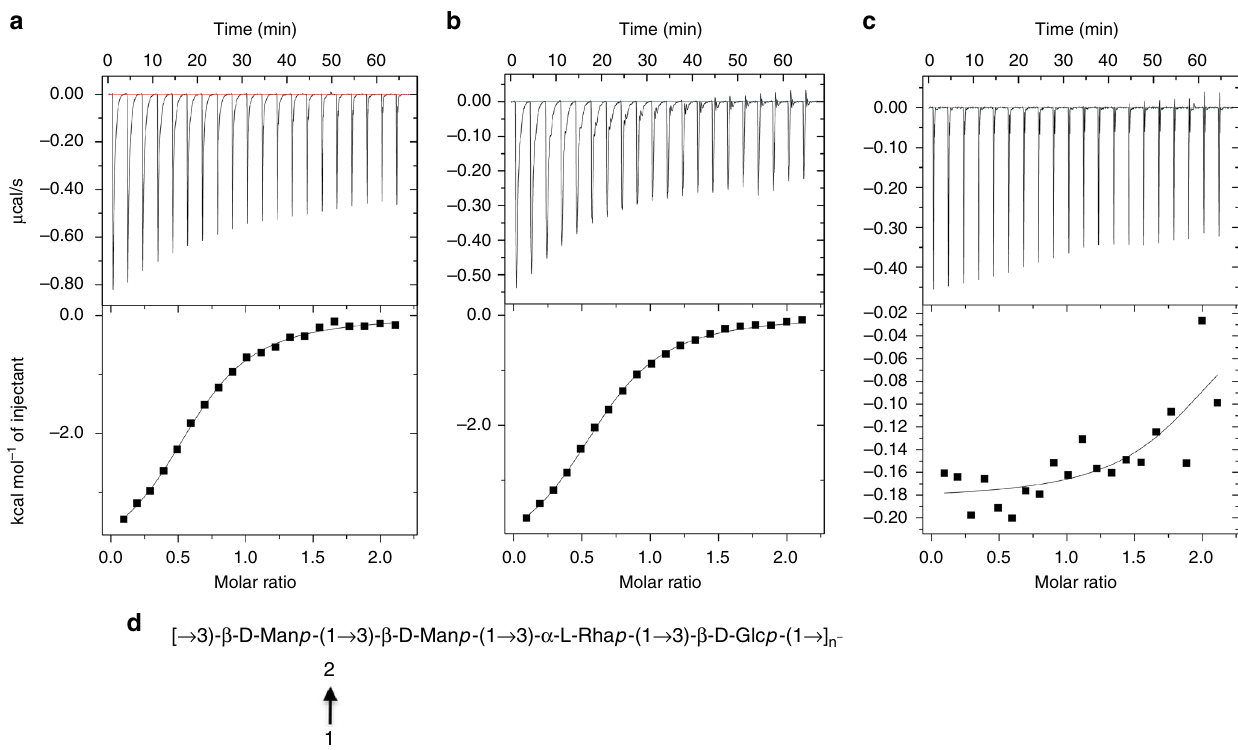
Fig. 2 LecB binds α -mannobiose, but not β -mannobiose. Titration of a α -1,2 ′ mannobiose (Psl side chain) into puri fi ed LecB, b α -1,3 ′ mannobiose into puri fi ed LecB (not present in Psl), and c β -1,3 ′ mannobiose (Psl linear chain) into puri fi ed LecB. d Chemical structure of the Psl displaying the α -1,2 ′ mannobiose side chain and β -1,3 ′ mannobiose in linear chain NATURE COMMUNICATIONS| (2019) 10:2183